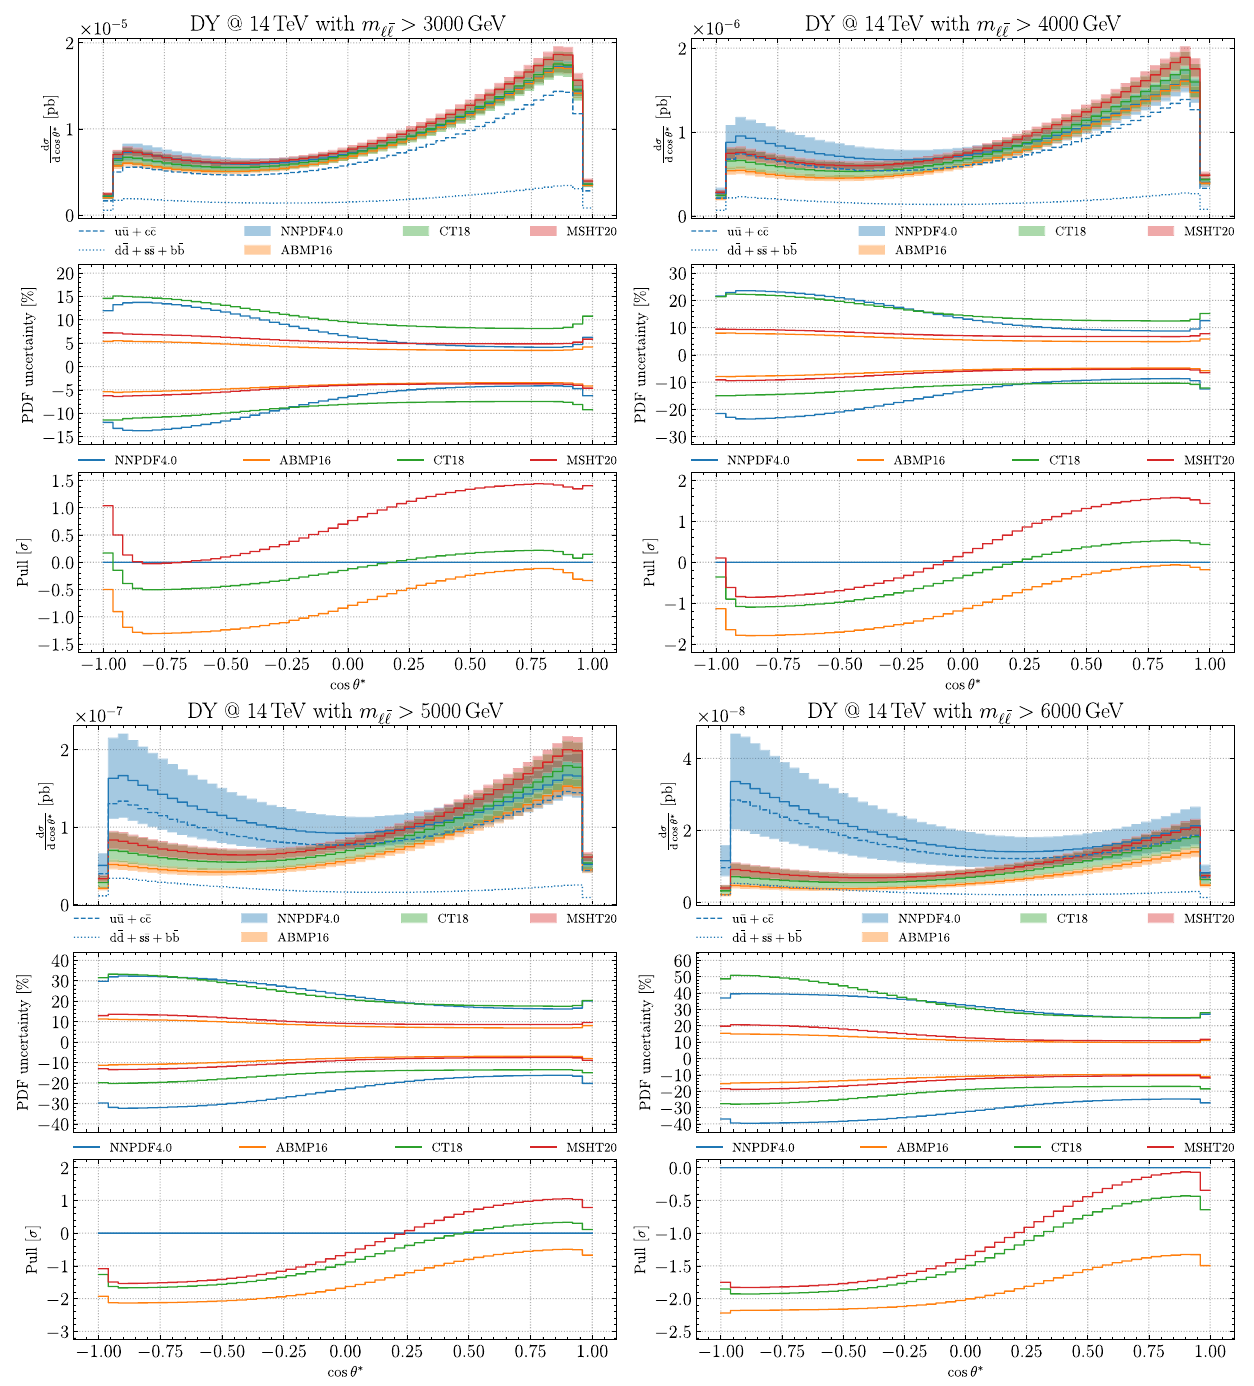
Fig. 19 Same as Fig. 18 (left) for different values of the lower cut in the dilepton invariant mass: m (cid:2) ¯ (cid:2) ≥ 3 , 4 , 5 , and 6 TeV